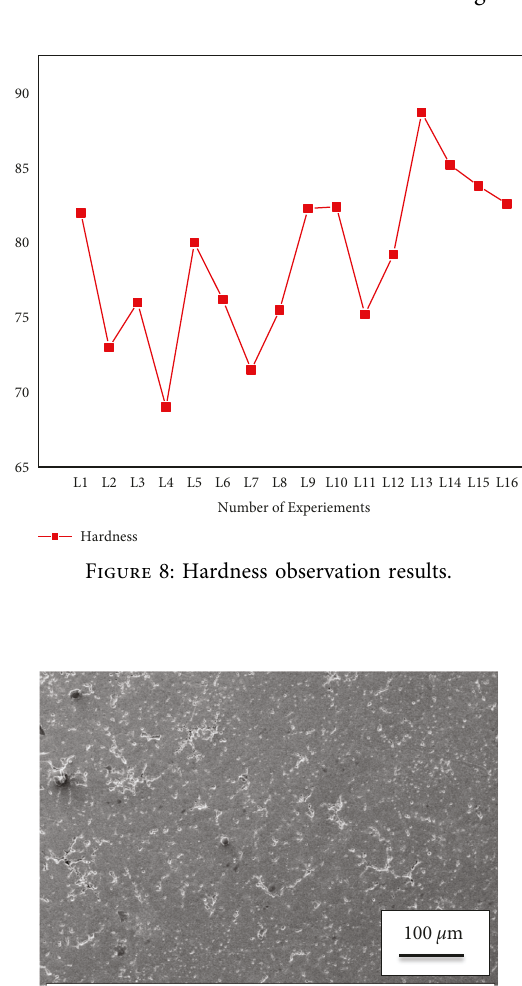
Figure 9: Microstructure image of the tensile fractured surface for an insignificant parameter